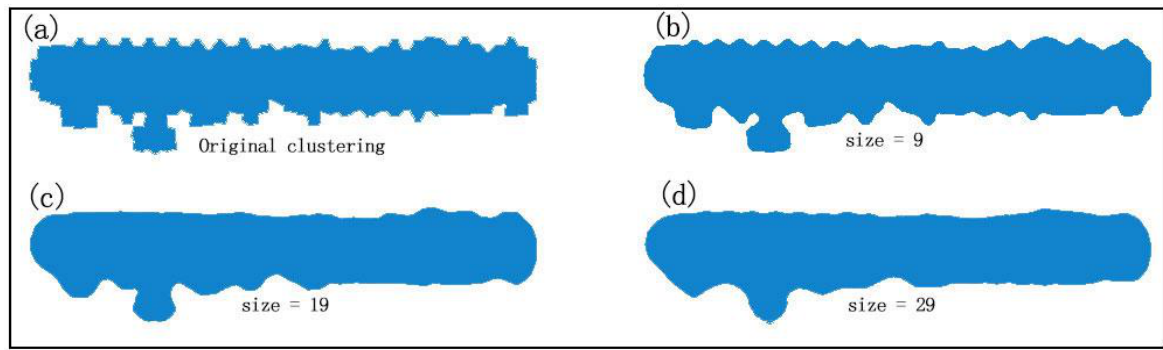
Figure 4. Median filtering in typification regions of buildings. ( a ) original shape. ( b ) Median filter size 9 results. ( c ) Median filter size 19 results. ( d ) Median filter size 29 results.